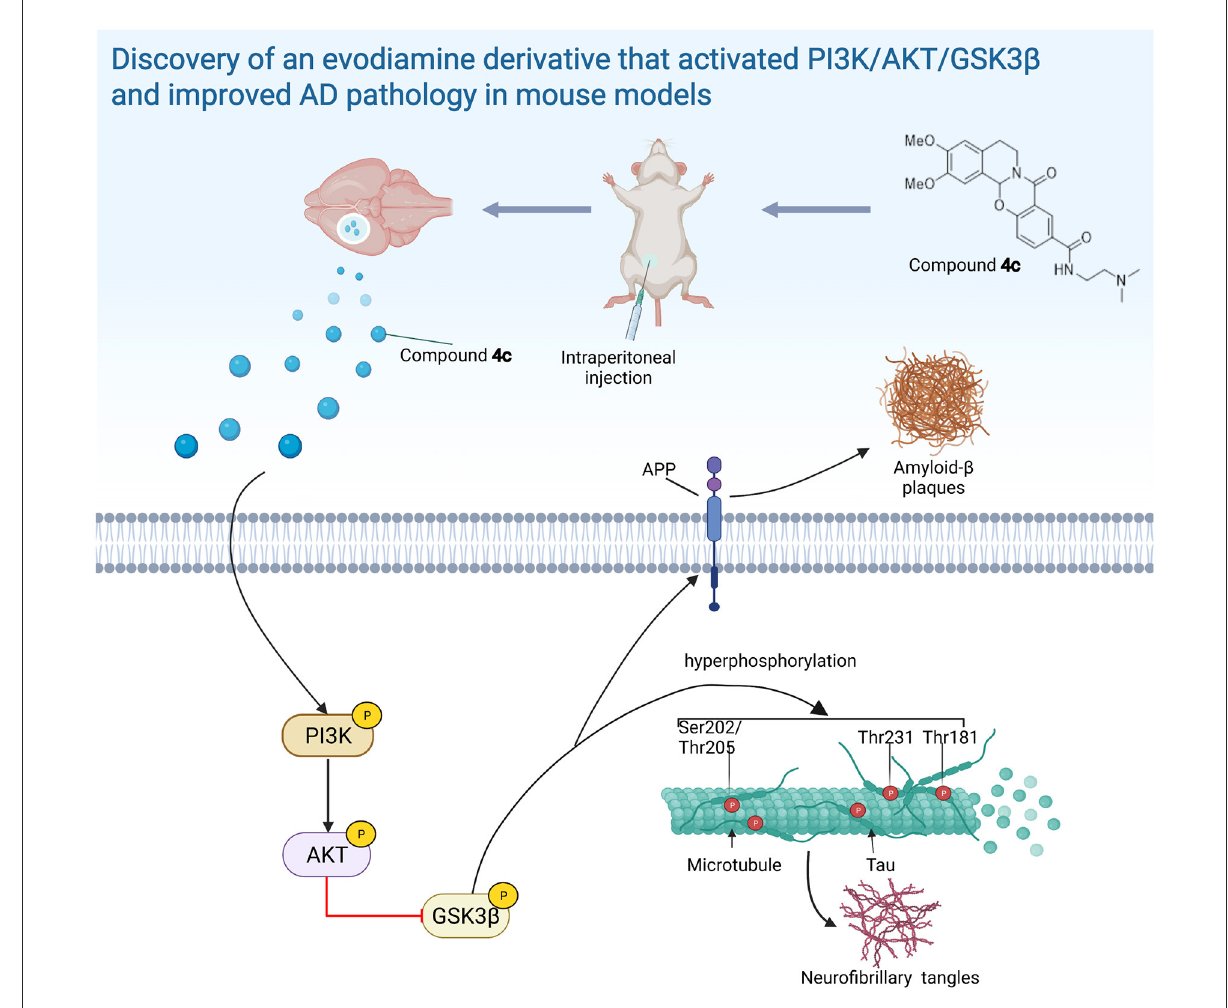
FIGURE10 The evodiamine derivative 4c improves AD pathology via the PI3K/AKT/GSK3 β pathway. Compound 4c reversed the impairment of the PI3K/AKT/GSK3 β signaling pathway in AD mice, thereby improving AD pathology (diagram was created with